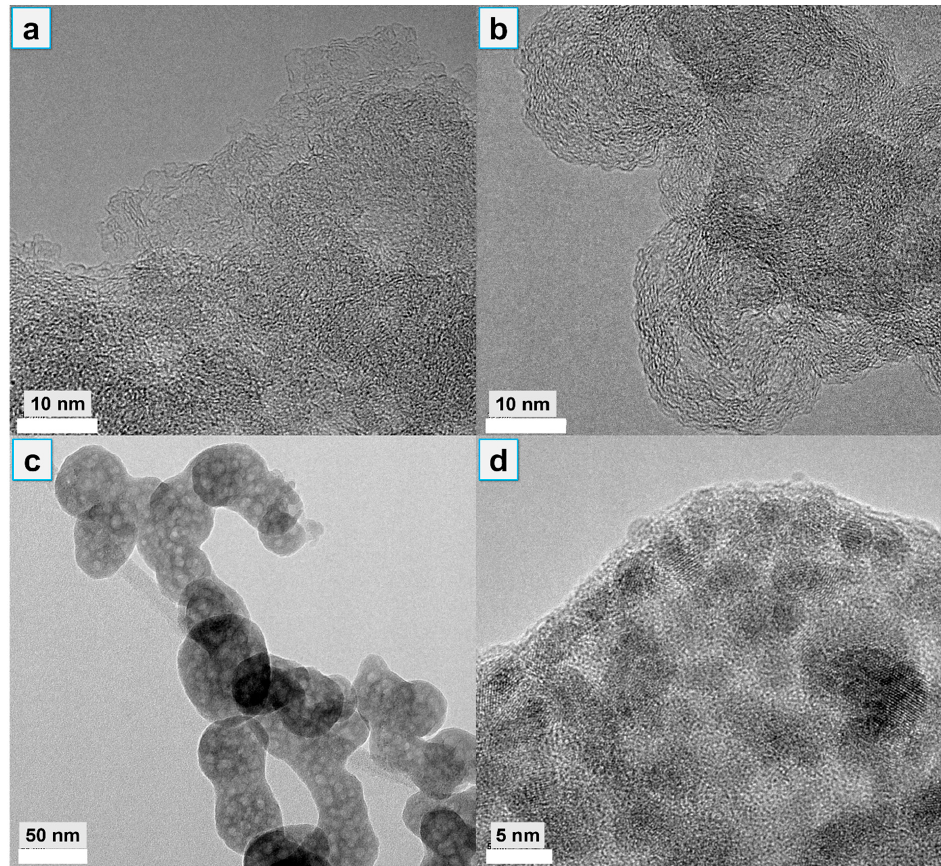
Figure 10. High-magnification TEM images of surface char: C-rich region in 25% APP/DPER ( a ) and 25% APPZ4/DPER ( b ); Co-rich region in 25% APPZ4/DPER ( c , d ).